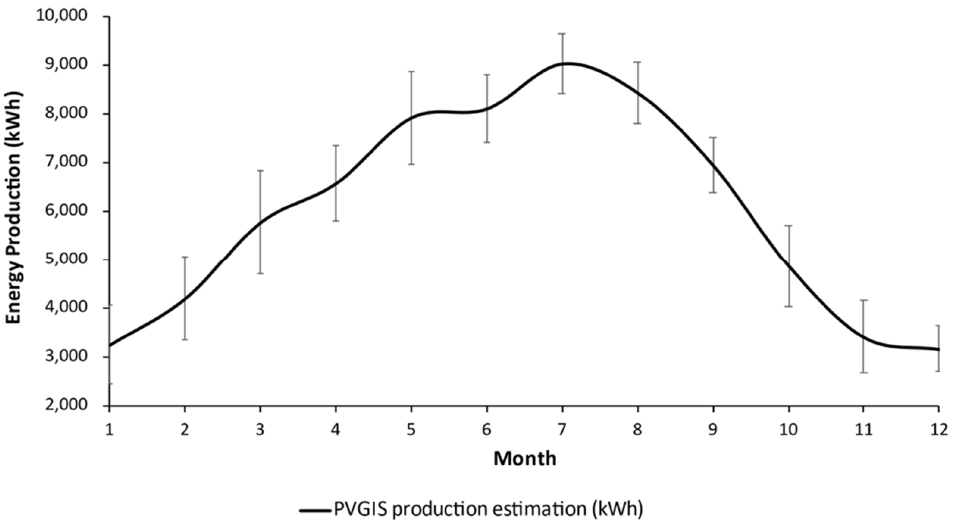
Figure 3. PV potential production estimated using the PVGIS platform, with the monthly average values and the corresponding standard deviations.